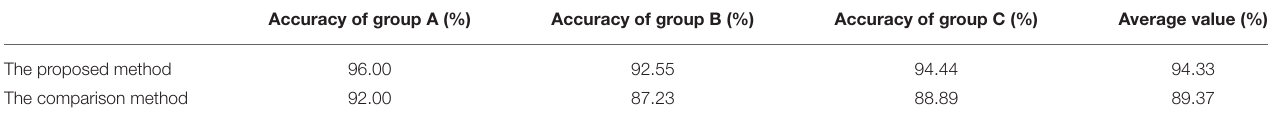
TABLE 3 | Analysis of recognition accuracy under different